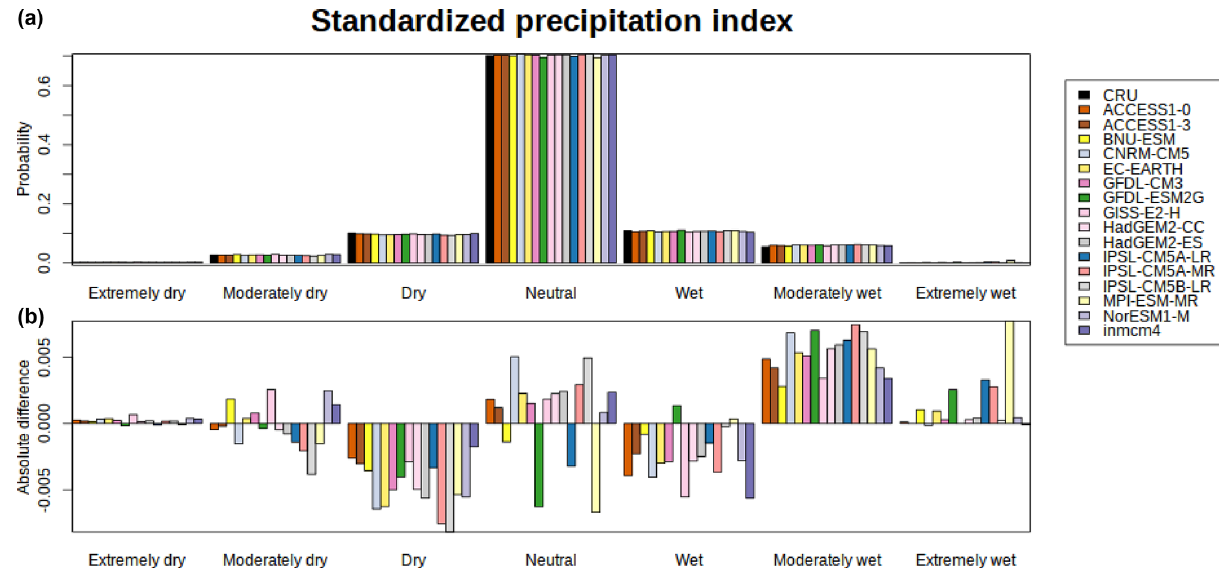
Figure 3. Output from SPI diagnostic in recipe_spei.yml with globally averaged histograms of SPI over land areas, weighted by the cosine of latitude for a selection of CMIP5 models and using gridded observations from CRUts4.01. (a) Absolute values and (b) bias of all models compared to CRUts4.01; for details see Sect. 3.1.2.